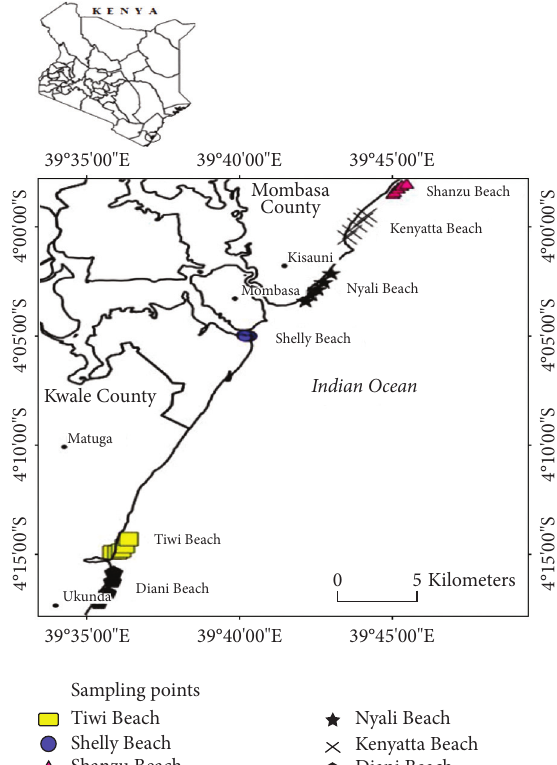
Figure 1: A map of the coastline of Kenya showing the sampling points in this work. The sampling points are indicated by the colored